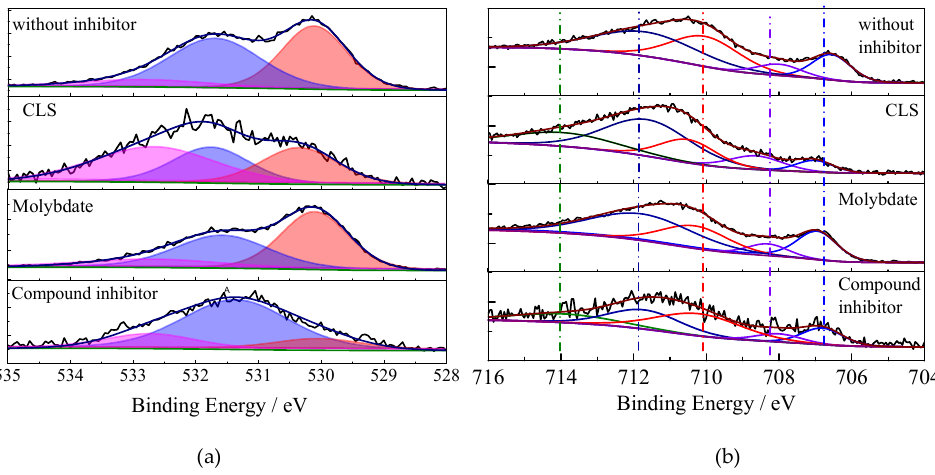
Figure 10. High-resolution XPS spectrum of Q235 carbon steel immersed in carbonation SCP solution with different inhibitors: ( a ) O 1s; ( b ) Fe 2p.